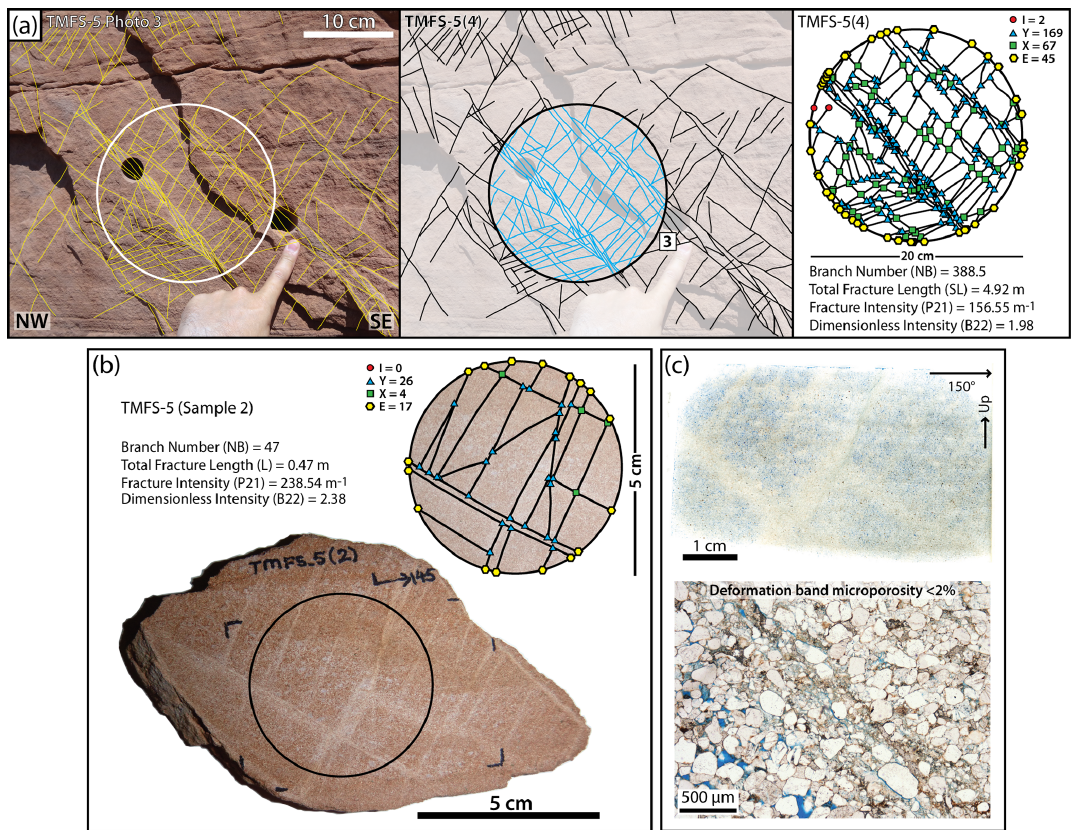
Figure 5. Example of fracture analyses undertaken at different scales in this study, sample TMFS-5. (a) Outcrop photograph with superim- posed fracture analysis circle showing the fracture network and associated I-, Y-, X- and E-nodes. (b) Hand specimen analysis (see Fig. 3). (c) Whole thin-section photograph (taken using flatbed scanner) and plain-polarised light (PPL) photomicrograph. Optical microscopy petro- graphical, porosity and microstructural analyses were carried out on thin sections cut from each hand specimen. Sections were impregnated with blue resin to highlight